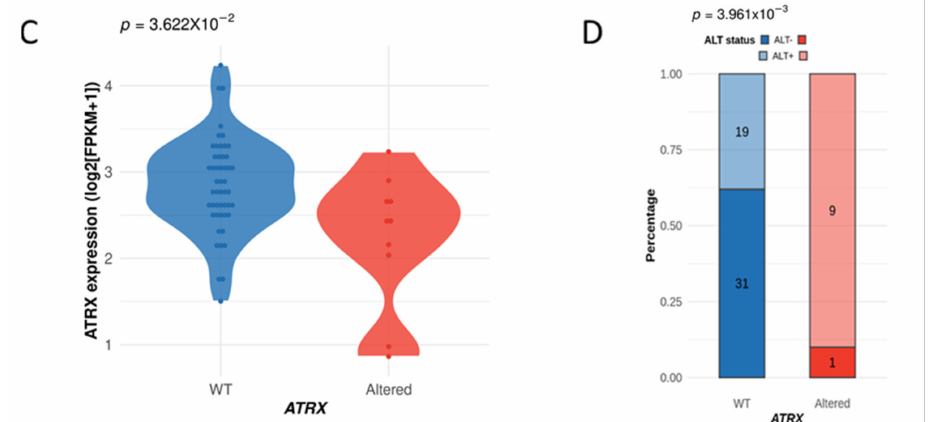
Figure 3. ATRX alterations and integrated representation in poorly differentiated pleomorphic sarcomas (cohort 2). ( A ) ATRX alterations are color-coded by their type, and shapes represent histotypes. Numbers in bubbles indicate a tumor sample (legend at the top). Translated consequences on ATRX protein is annotated above a protein schematic representation for mutations, or be-low for fusion transcripts. ( B ) Integrated representation shows ATRX alterations, mRNA expression (by quartile), ALT mechanism phenotype, histotypes, tumor site, FNCLCC grade, presence or not of metastasis and sex of each patient. Tumors are ordered by ATRX status, ALT phenotype, mRNA expression and histotypes. ( C ) Association between ATRX status and its mRNA expression (log2(FPKM+1)). ( D ) Relation between ATRX status and ALT